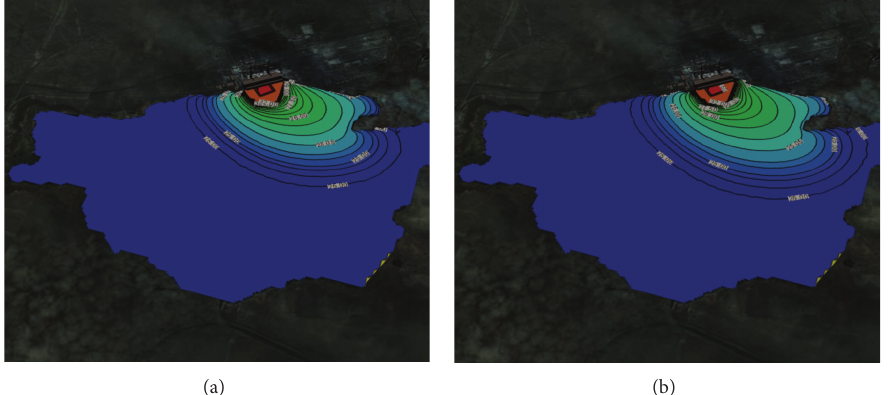
Figure 4: Outline and contours of temperature at 15 and 24 hours at the west wind after the launch of Ekibastuz SDPP-1 on the surface of the water and the top